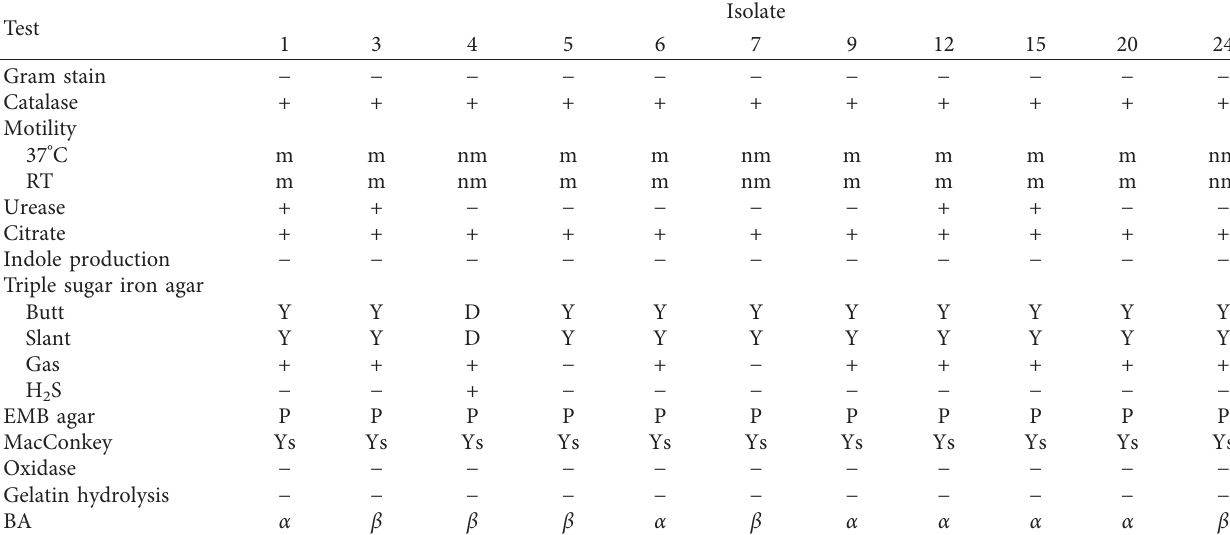
Table 3: Summary of the cultural and biochemical test results for dairy isolates used in this